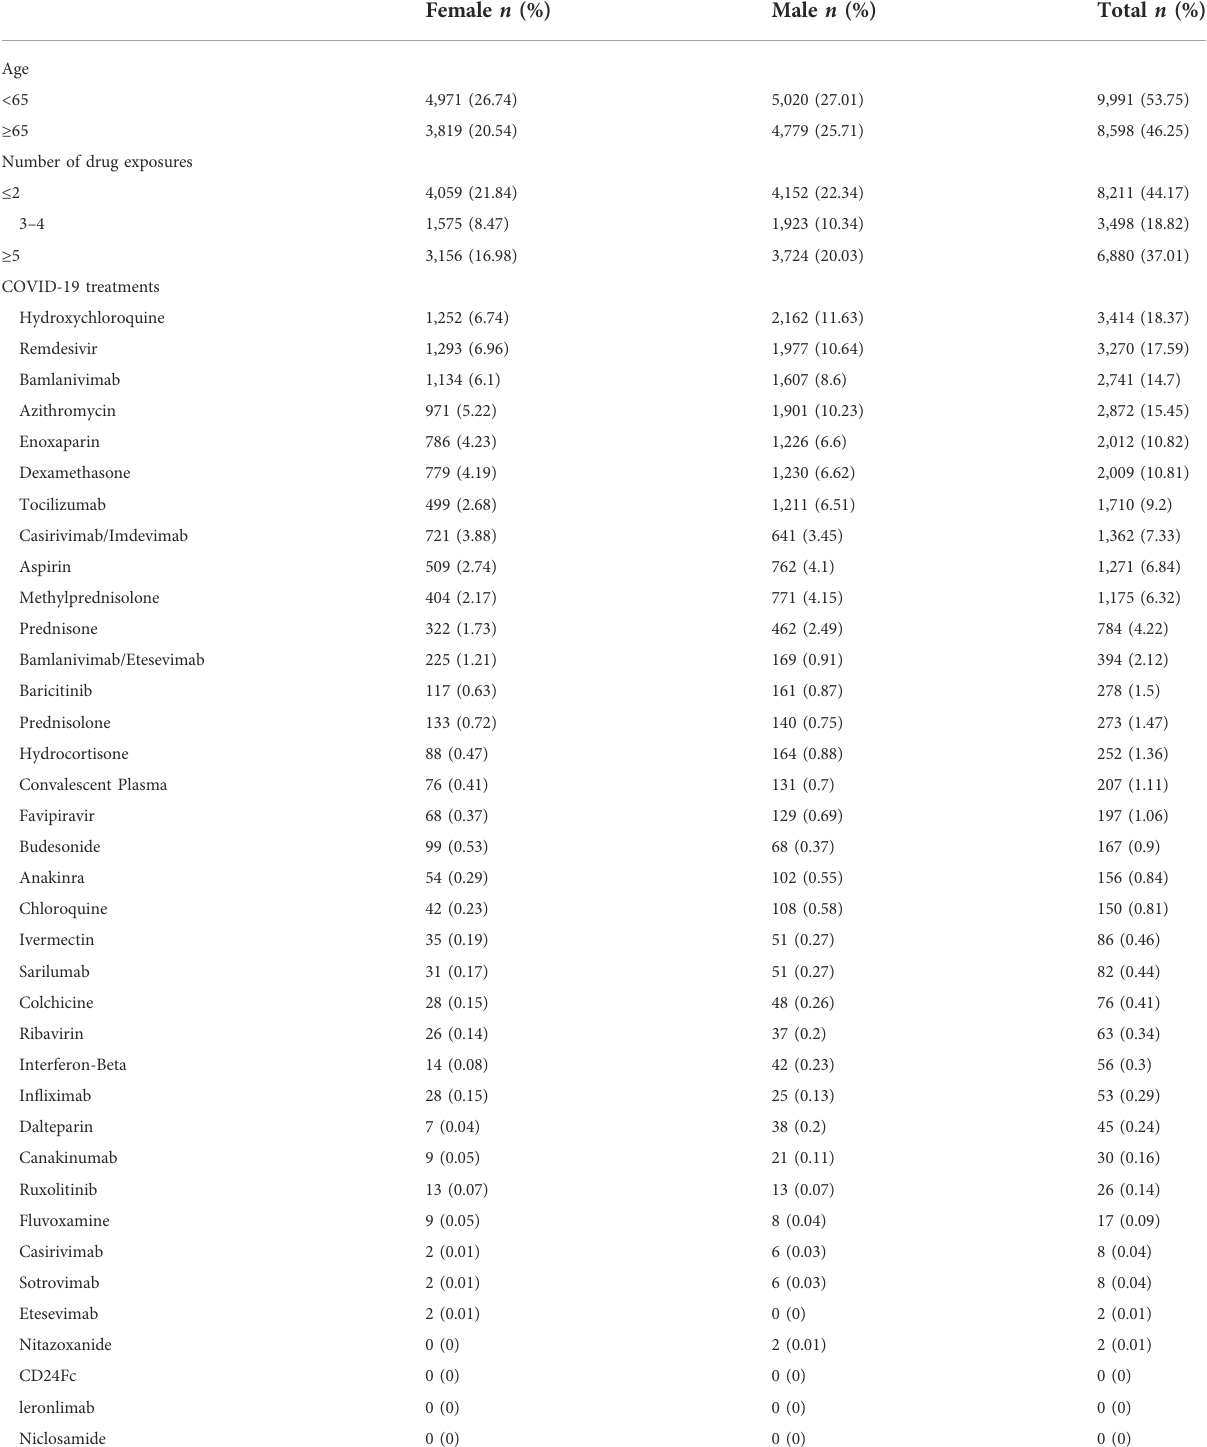
TABLE 1 Summary characteristics of the study population in the FAERS database from January 2020 to September